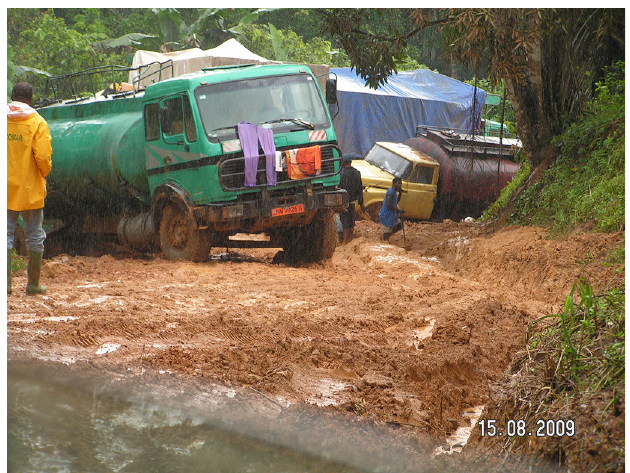
Fig. 2. Poor road for truck (untarred) during the rainy season (Photo J. Kenfack in Mbongue